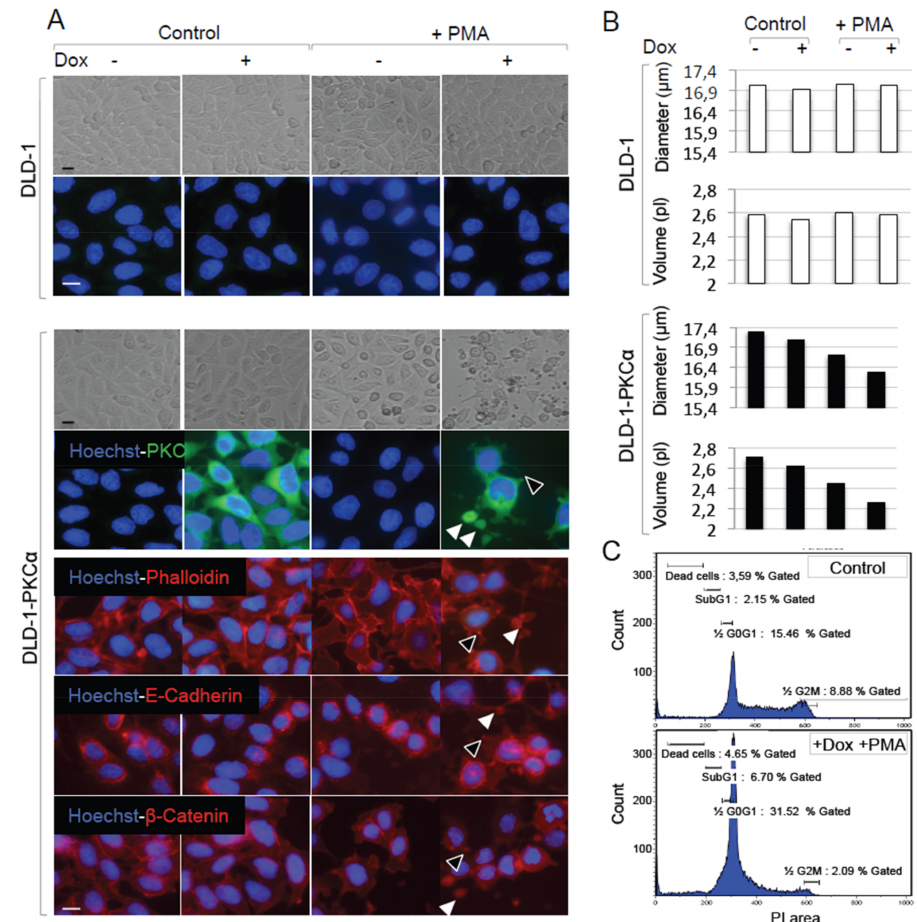
Figure 5. Inducing PKC α activity alters the shape, decreases the size, and stops cell cycling in DLD-1-PKC α CRC cells. ( A ) Parental and DLD-1 cells in which PKC α can be induced by doxycycline (DLD-1-PKC α cells) were incubated or not with 1 µ M doxycycline (to induce PKC α expression) and / or 1 nM PMA (to induce PKC activity) for 24 h and were observed by phase contrast (first and third line) or by epifluorescence microscopy. Hoechst staining of the nuclei (blue) and staining for PKC α (green), actin (red; phalloidin), E-cadherin (red) and β -catenin (red), as indicated, show that increasing PKC α function in DLD-1-PKC α cells (doxycycline + PMA) alters cell morphology and induces a strong remodeling of the actin-E-cadherin- β -catenin network. Note the localization of overexpressed PKC α , actin, E-cadherin and β -catenin in membrane protrusions (empty arrowheads) and large buds (solid arrowheads) upon incubation with doxycycline and PMA (scale bar: 5 µ m). ( B ) Scepter measurements carried out in DLD-1 control cells (upper panel) and DLD-1-PKC α cells (lower panel) exposed or not to 1 µ M doxycycline and / or 1nM PMA for 24 h, show that increasing PKC α function in DLD-1-PKC α cells (doxycycline + PMA) significantly decreases the cell volume and diameter. ( C ) Flow cytometry analysis of DLD-1-PKC α cells exposed (lower panel) or not (Control, upper panel) to doxycycline